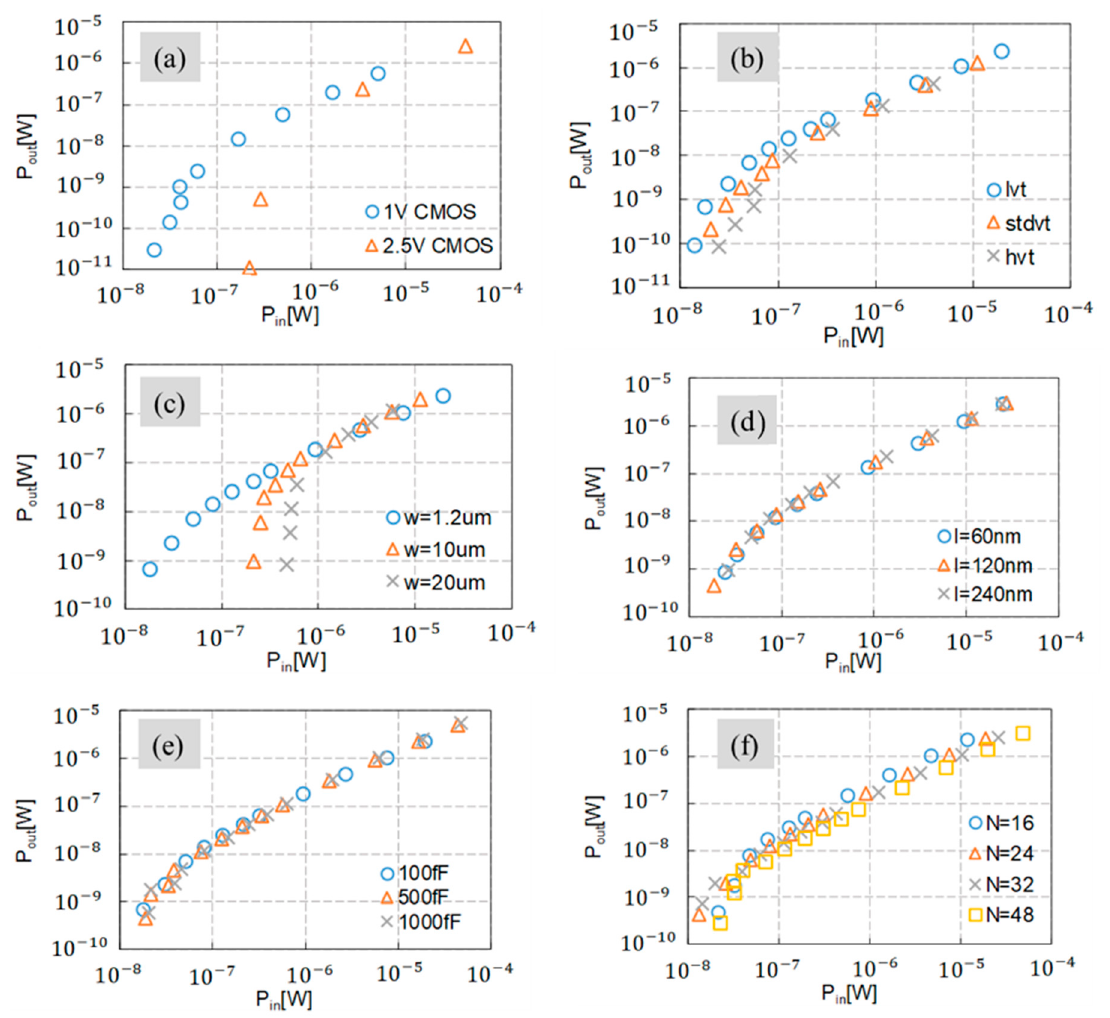
Figure 5. P in − P out with variations of CMOS ( a ), V TH ( b ), total gate width (W × nf) ( c ), L ( d ), Cin ( e ) and N ( f ).